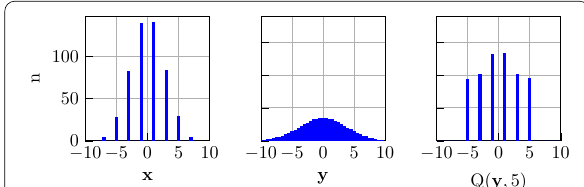
Fig. 7 Histogram of encoded vector x with D = 512 and V = 7 , received vector y at 0 dB SNR, and readout-quantized vector with V ′ =